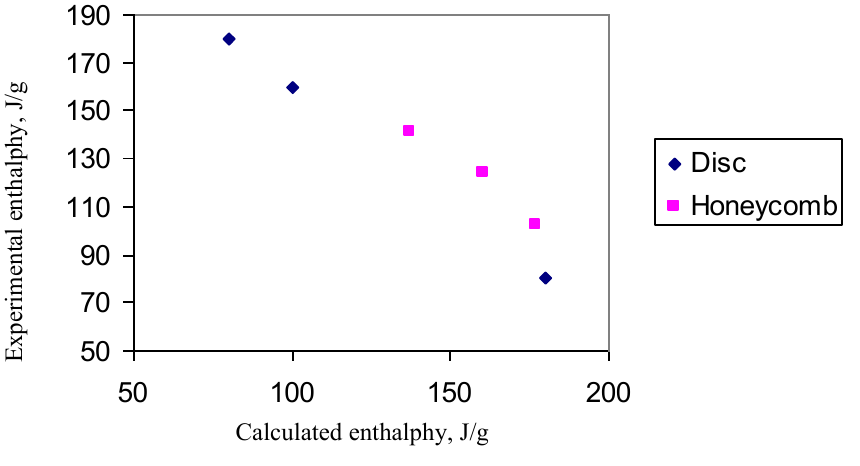
Figure 5 . Immersion enthalpy experimental as function of immersion enthalpy calculated by the equation Stoeckli-Kraehenbuehl. Equation: Y= 0,702X + 212,12, R 2 = 0,995.